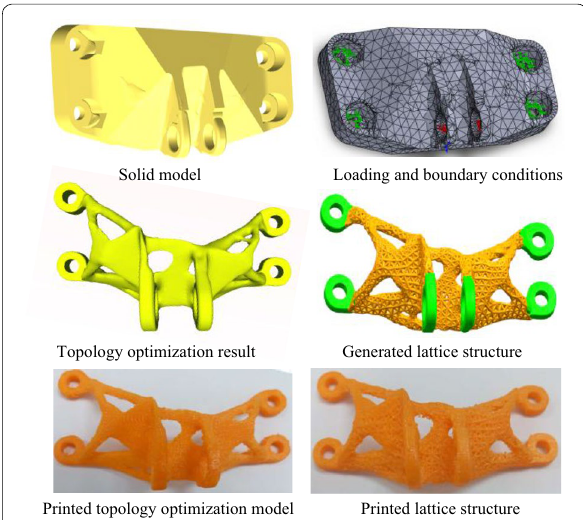
Figure 10 Generated procedure of jet engine bracket with lattice